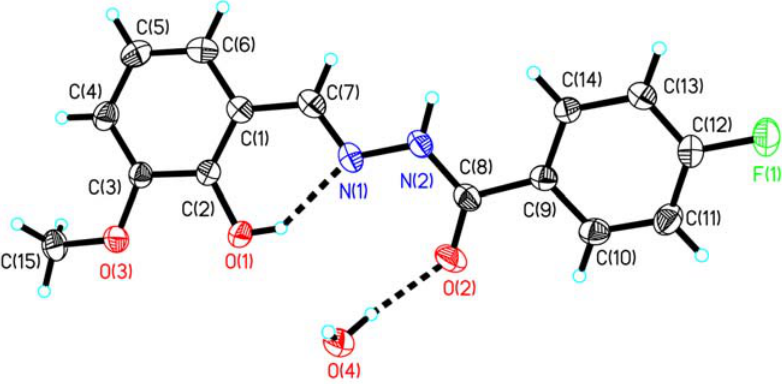
Figure 1. Molecular structure of H L · H2O. Displacement ellipsoids are drawn at the 30% probability level and H atoms are shown as 2 small spheres of arbitrary radii.